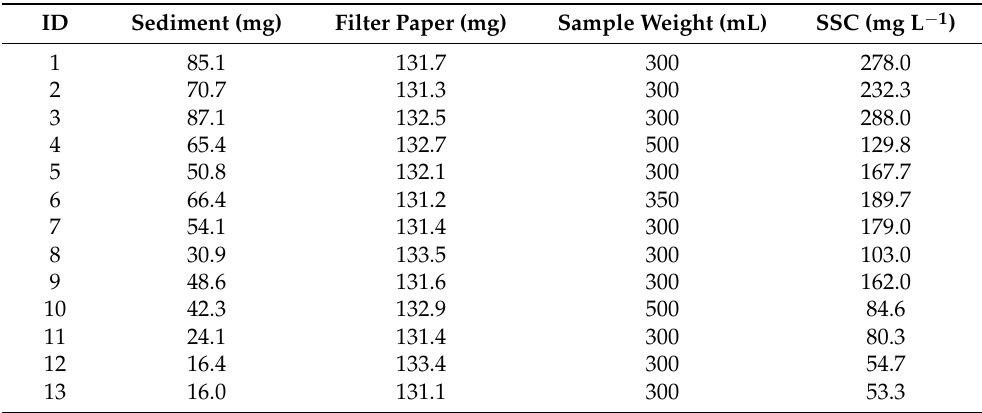
Table 2. SSC data analyzed in the